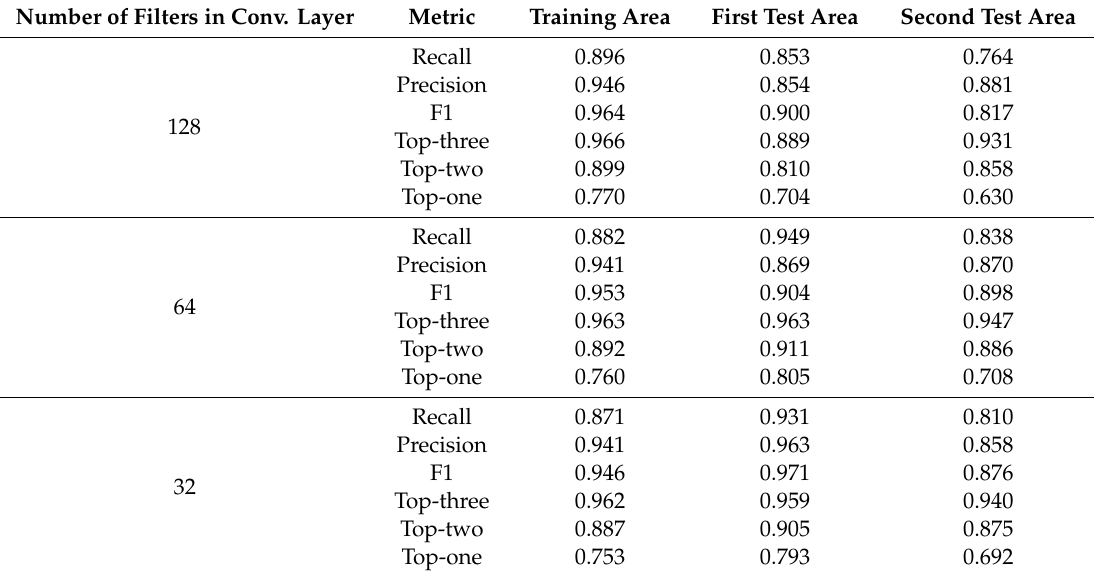
Table 3. Impact of the number of convolutional filters on the feature extraction (CNN-1) for the first and second datasets.